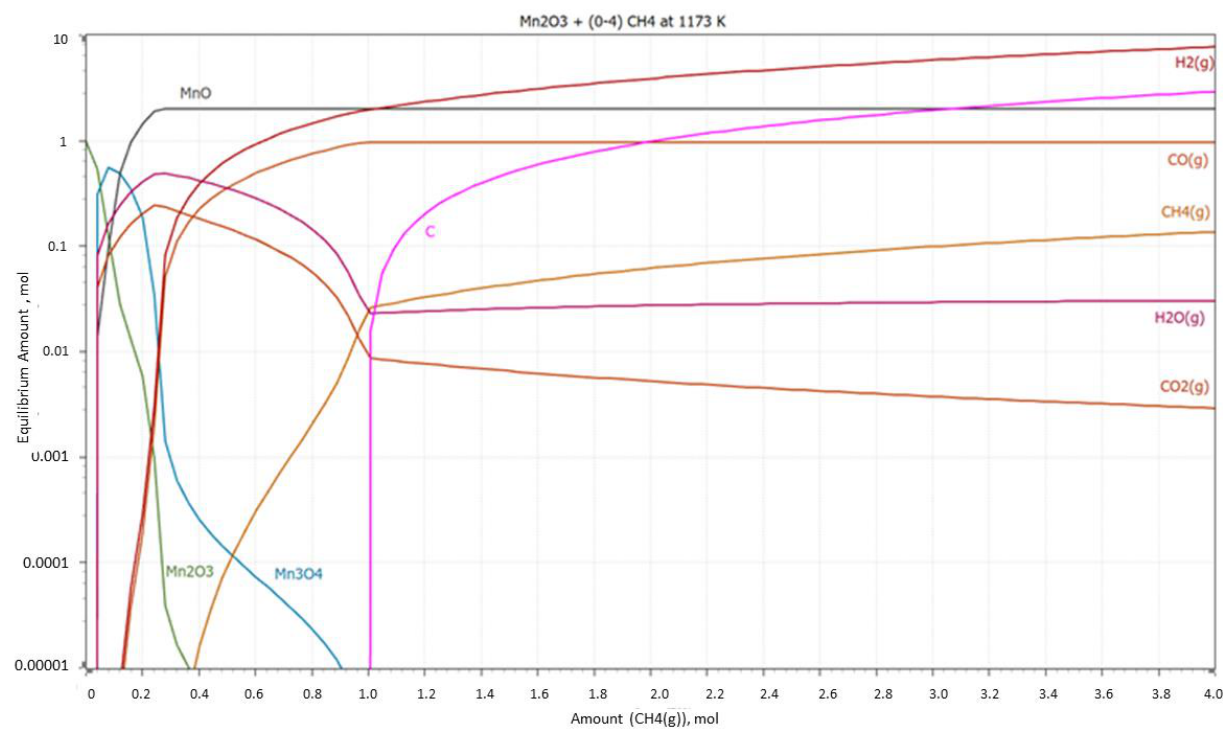
Figure 11. Equilibrium calculations when 1 mole of Mn 2 O 3 reacts CH 4 (g) at 1173 K. Created using the equilibrium calculations module in HSC Chemistry 9.